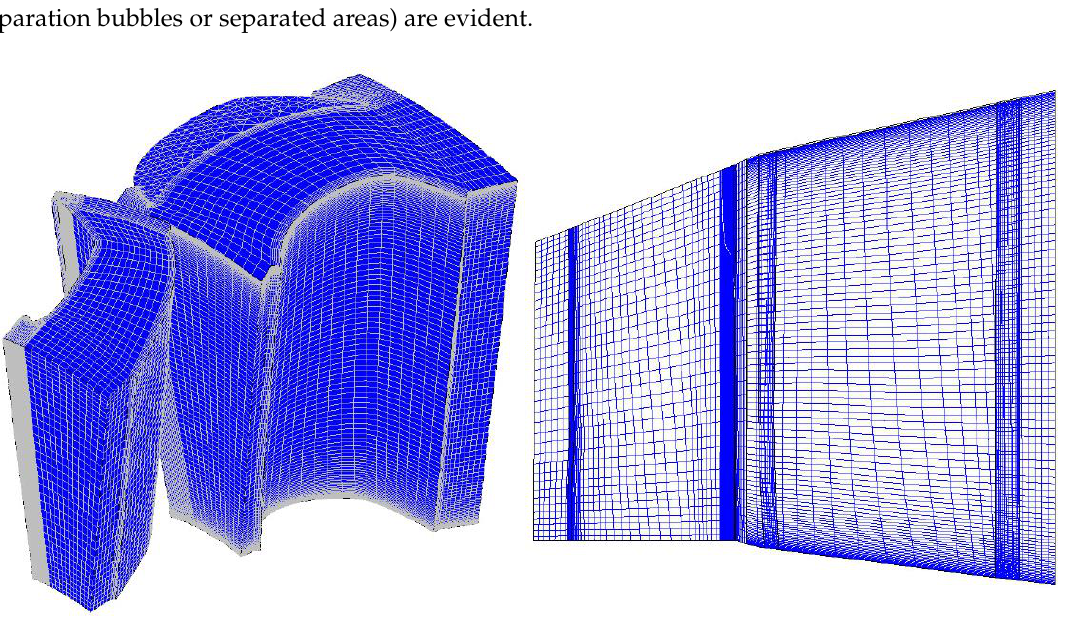
Figure 33. 3D CFD mesh details.